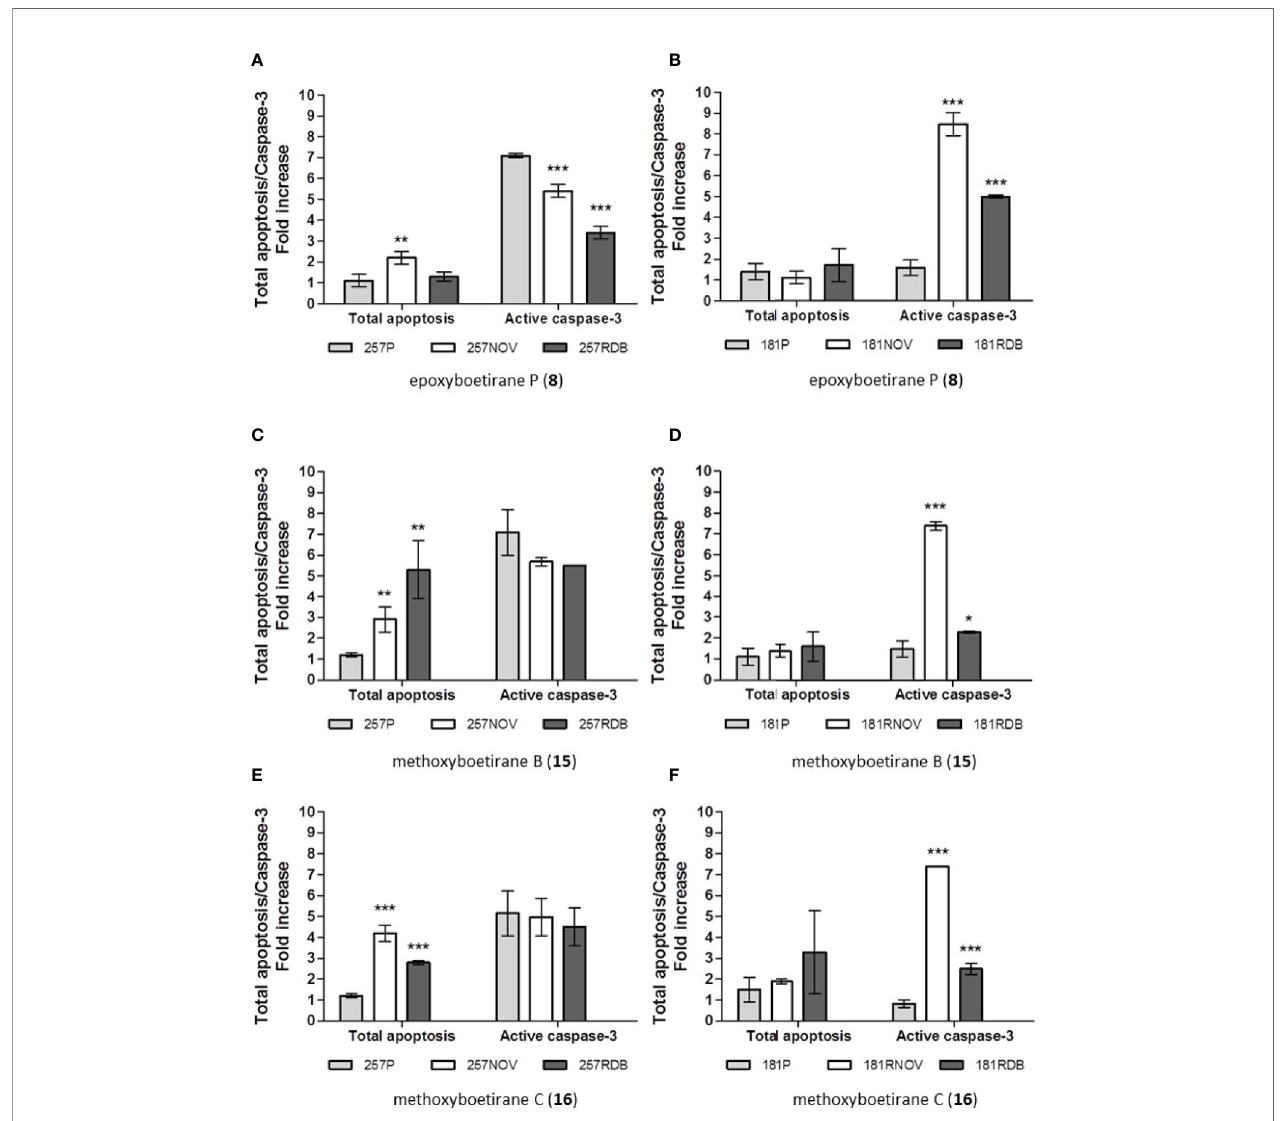
FIGURE 2 | Cell death mechanism measurements: apoptosis induction and active caspase-3 activation in gastric ( A, C, E ) and pancreatic ( B, D, F ) cancer cell lines after 72 h incubation with epoxyboetirane P ( 8 ), methoxyboetirane B ( 15 ), and methoxyboetirane C ( 16 ) (30 m M). Apoptosis induction: representative fl ow cytometry analysis after annexin V-FITC/PI staining. The FL1 and FL2 axis represent the fl uorescence intensities of Annexin V-FITC and PI, respectively. Camptothecin (1 m M) was used as internal positive control. Total apoptosis was considered the sum of early and late apoptotic events (cells annexin V-FITC positive/PI negative plus cells annexin V-FITC positive/PI positive). The results were expressed as the ratio between treated samples with untreated. Each column represents the mean ± SD of three independent experiments. Statistical signi fi cance was calculated for the difference between treated resistant cell lines and treated parental cells using a two- tailed unpaired Student ’ s t test. Level of signi fi cance *, p < 0.05. **, p < 0.01. ***, p < 0.001. Active caspase-3: the results were expressed as the ratio between treated samples with untreated. Each column represents the mean ± SD (n = 3). Statistical signi fi cance was calculated for the difference between treated resistant cell lines and treated parental cells using a two-tailed unpaired Student ’ s t test. Level of signi fi cance *, p < 0.05. **, p < 0.01. ***, p <